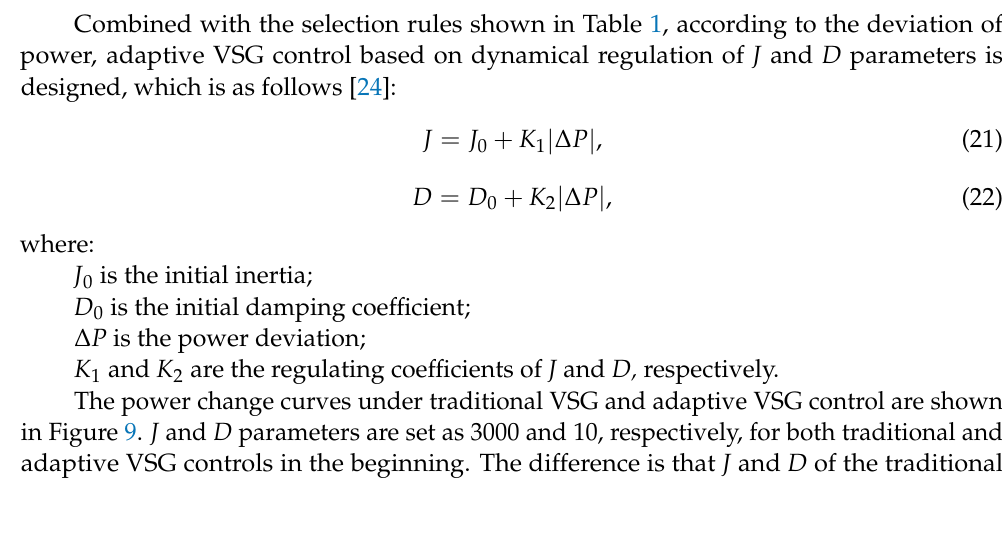
Table 1. Selection rules of J and D .